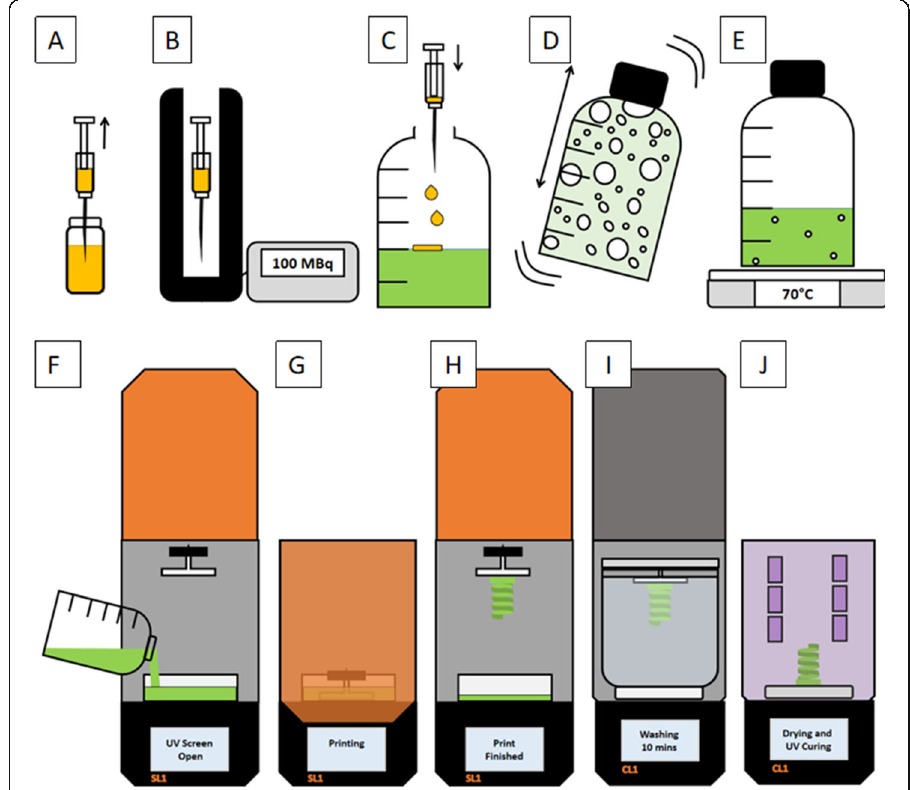
Fig. 1 18 F-FDG is drawn up into a syringe ( a ) and assayed using a radionuclide calibrator ( b ). The required amount of 3D-printing resin and the activity are added to a volumetric bottle ( c ). The bottle is sealed and vigorously shaken for 10 s ( d ). The bottle is placed on a heating plate for 10 min to prepare the resin for printing by helping to remove the bubbles ( e ). The radioactive resin is added to the printer ( f ), the UV protective cover is closed ( g ), and the print is started. When the print is finished ( h ), the build plate is transferred to the lid of the IPA cleaning tank ( i ), and printed objects are cleaned for 10 min. After the washing, the object is removed from the build plate and then dried using hot air and cured with UV radiation for 5 min each ( j